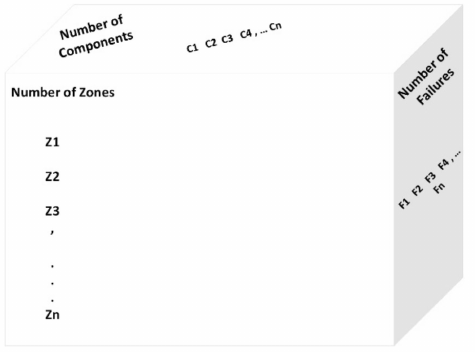
Figure 3. An example of the 3-dimensional matrix for the FI attributes. Structure room component combination matrix (1:number of structures, 1:number of rooms, 1:number of components) = (1:1, 1:6, 1:4) Fault injection time matrix (1:number of failures, 1:number of structures, 1:number